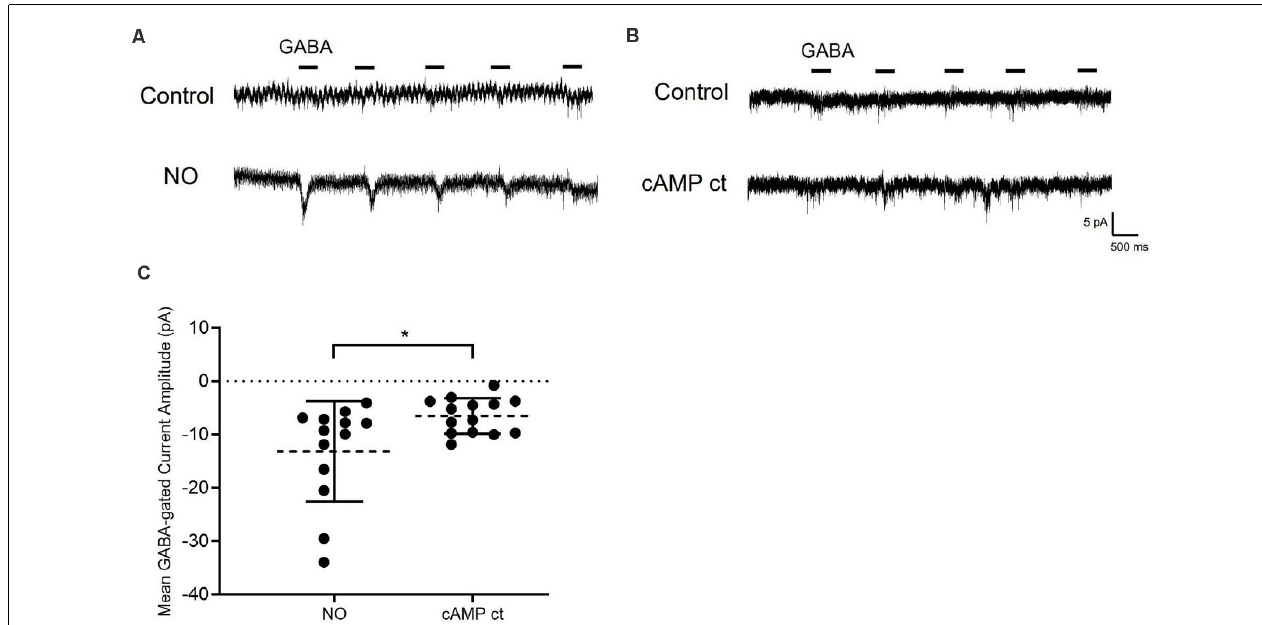
FIGURE 5 | Elevating cAMP in the absence of NO promotes Cl − release from the internal store. (A) Sample traces from cells are held at − 70 mV with GABA (20 µ M) applied for 400 ms. In the presence of NO, a GABA-gated inward current appears indicating that Cl − had been released into the cytosol. (B) In different cells, exposure to a cocktail of reagents selected to elevate cAMP (cAMP ct: forskolin, 1 µ M; 8-bromo-cAMP, 100 µ M; IBMX, 20 µ M) but no NO, results in a small GABA-dependent inward current. (C) The quantified mean GABA-gated current amplitude ± SEM; NO, n = 13; cocktail, n = 14. * P < 0.05 (Welch’s unpaired t -test).